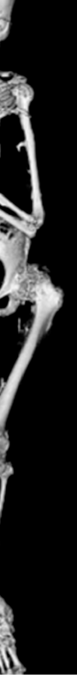
Figure 2. Whole body computed tomography imaging of 26-year-old male with FOP showing severe rigid scoliosis and bilateral hip joint contractures due to heterotopic ossifications across the joints.